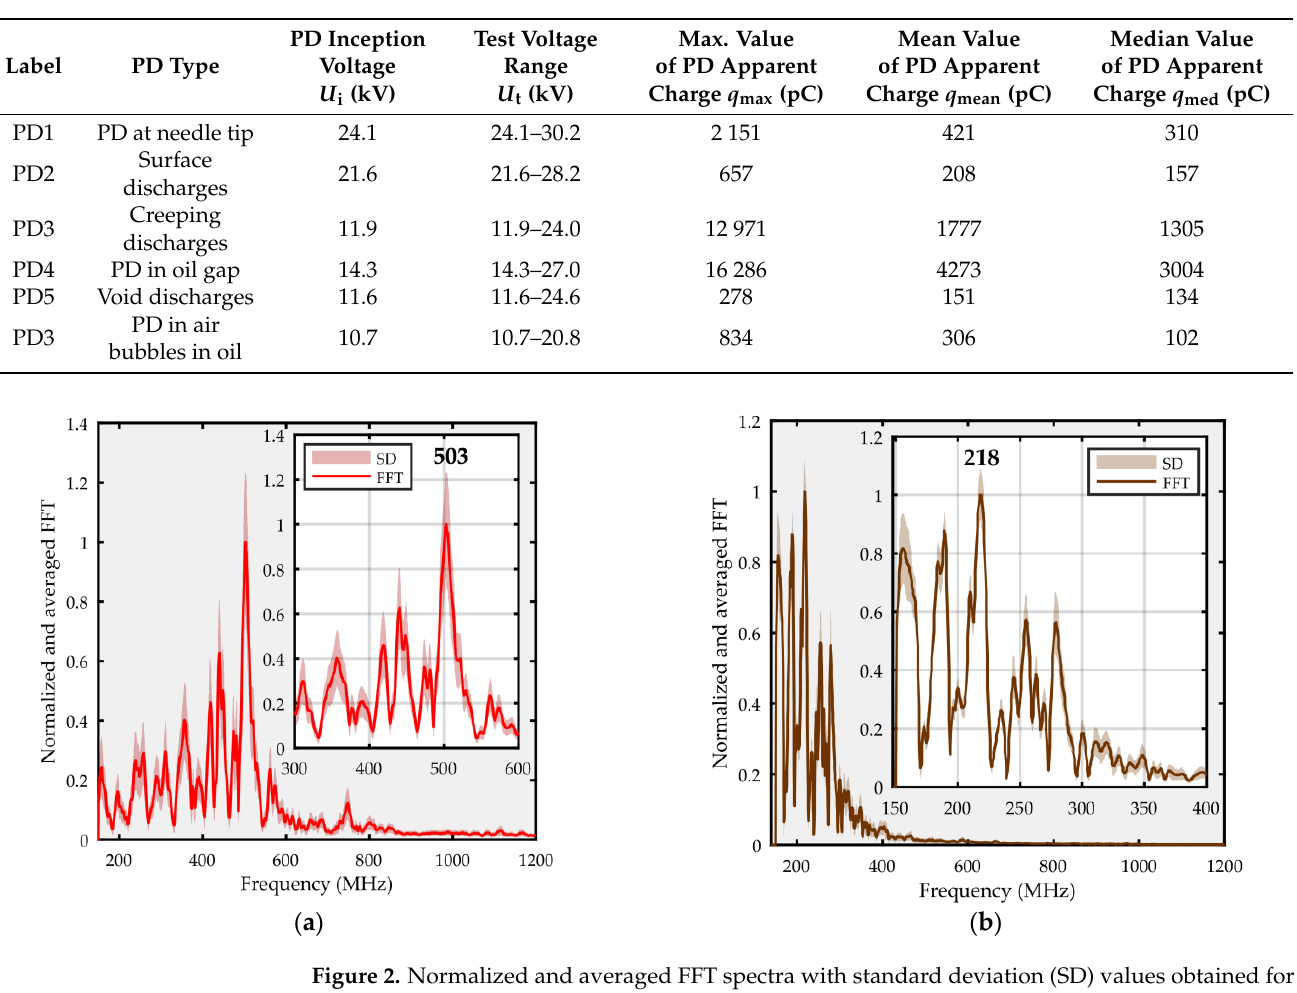
Table 2. Parameters of the investigated types of PDs.